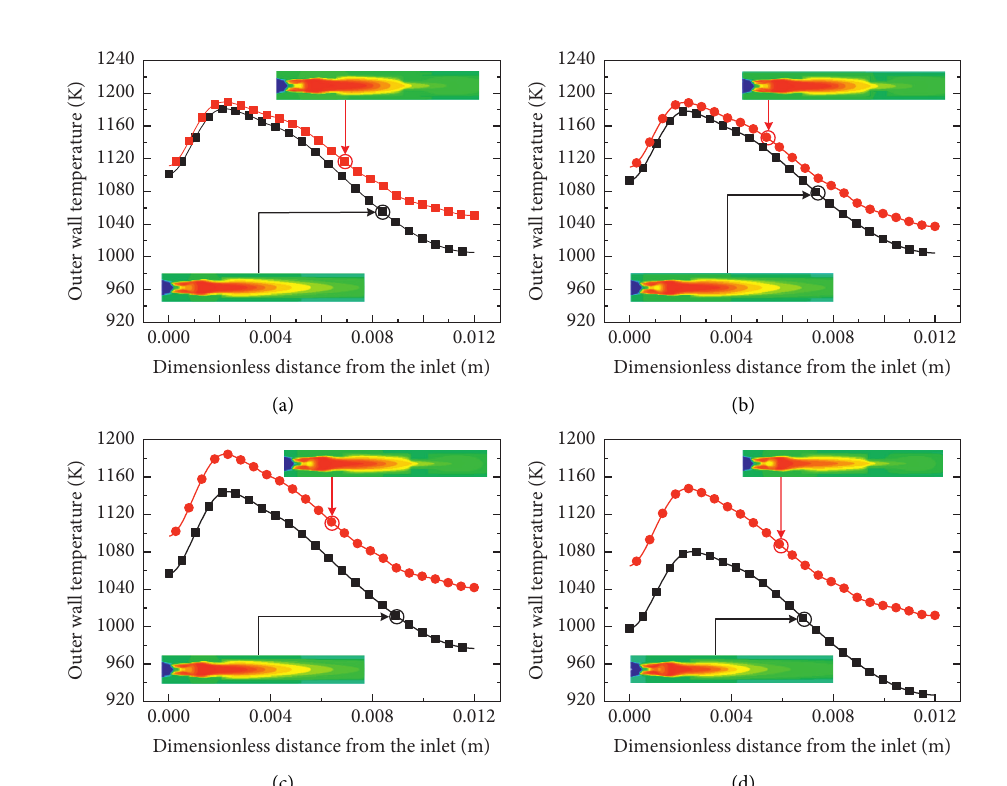
Figure 15: Comparison of outer wall temperature distribution at various equivalent